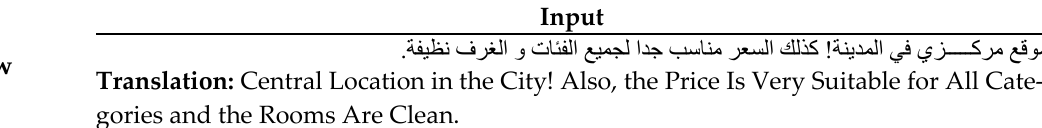
Table 7. Example of a user review after each of the preprocessing